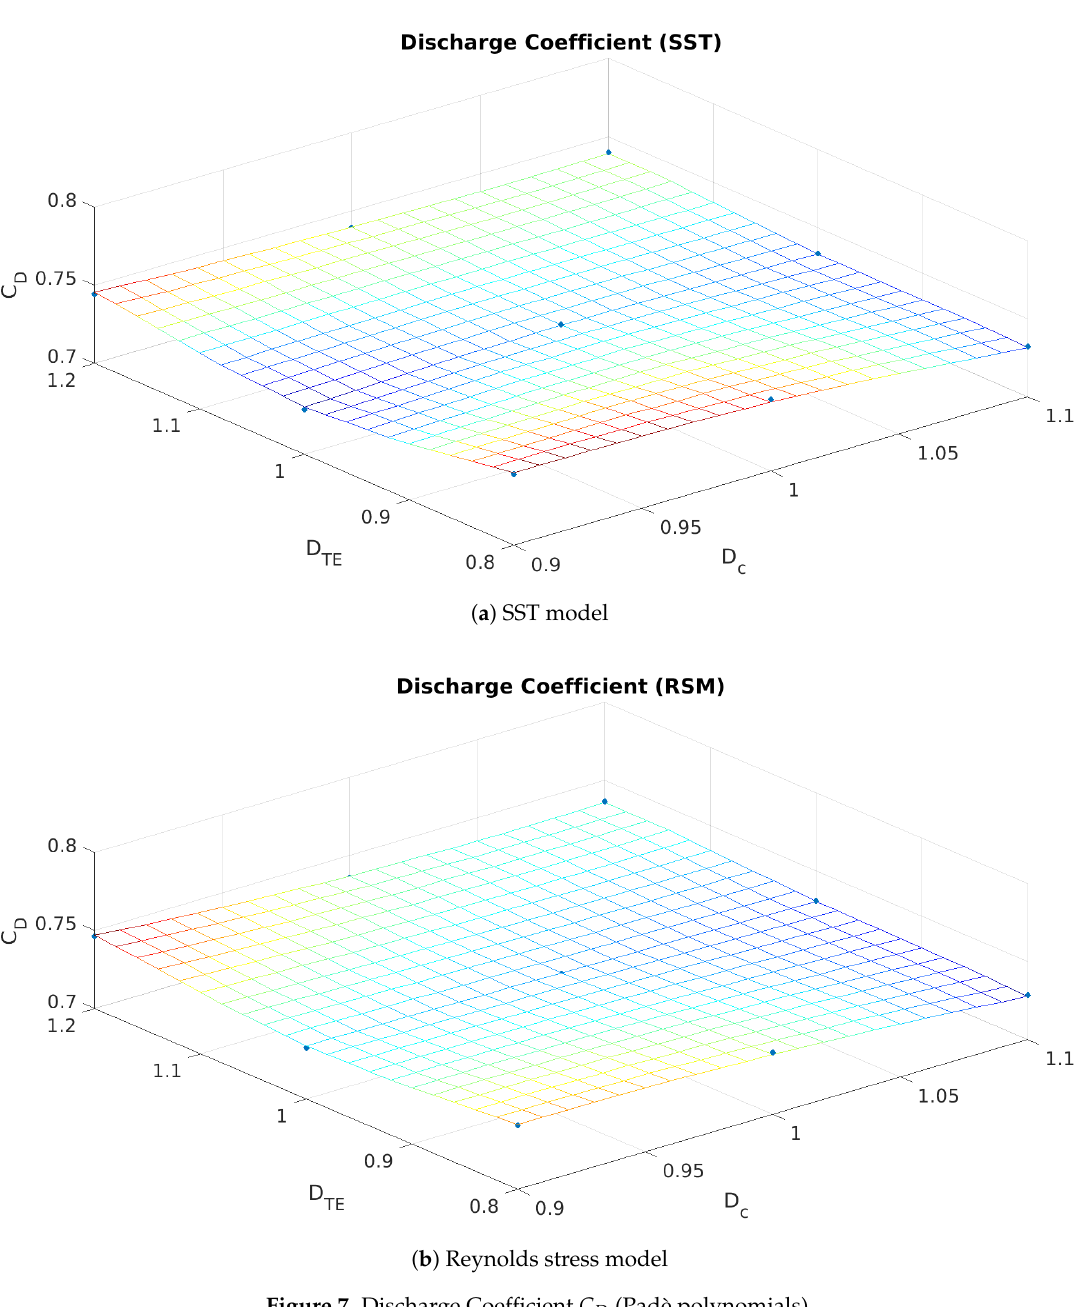
Figure 7. Discharge Coefficient C D (Padè